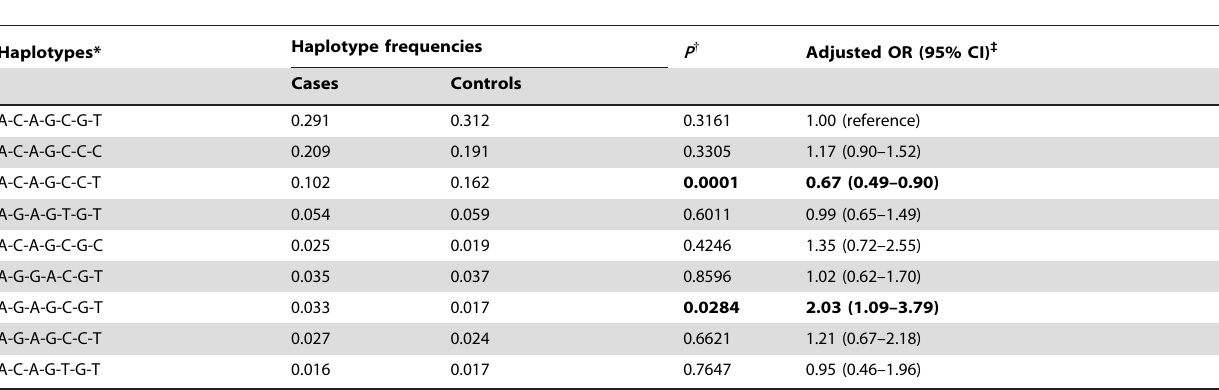
Table 8. Associations between risk of PER and frequencies of inferred haplotypes on the basis of the observed genotypes among cases and